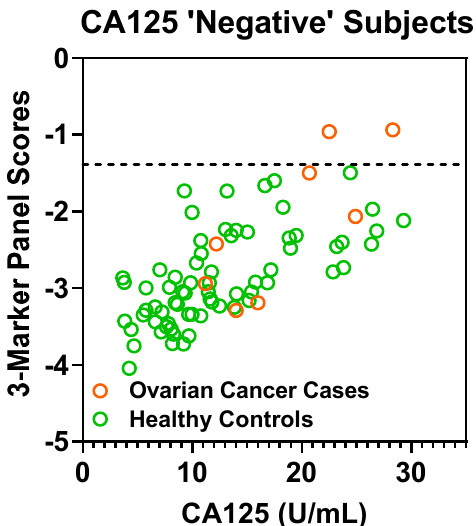
Figure A3. Plasma levels of polyamines in cases stratified by histology and controls in the Validation Set.